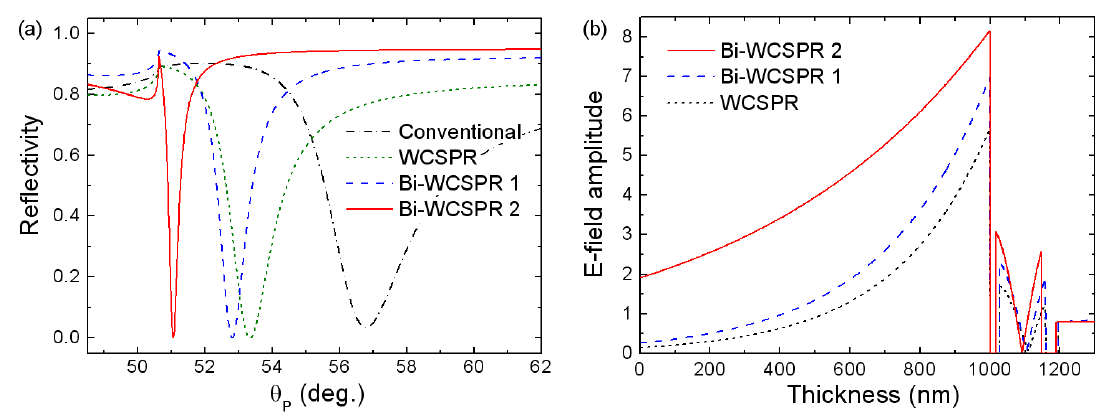
Figure 2. (a) Simulated SPR reflectivity curves and (b) local field distribution near the Au surface for some model configurations, where the WCSPR, Bi-WCSPR1, and Bi-WCSPR2 represent the multilayer stacks of SF10 prism/Au(35 nm)/ZnS-SiO (131 nm)/Au(28 nm) 2 (dotted line), SF10 prism/Ag(35 nm)/ZnS-SiO (131 nm)/Au(28 nm) (dashed line), and 2 SF10 prism/Ag(42 nm)/ZnS-SiO (131 nm)/Au(16 nm) (solid line), respectively. The 2 conventional SPR with a single Au layer (50 nm) was also included for comparison (dot-dashed